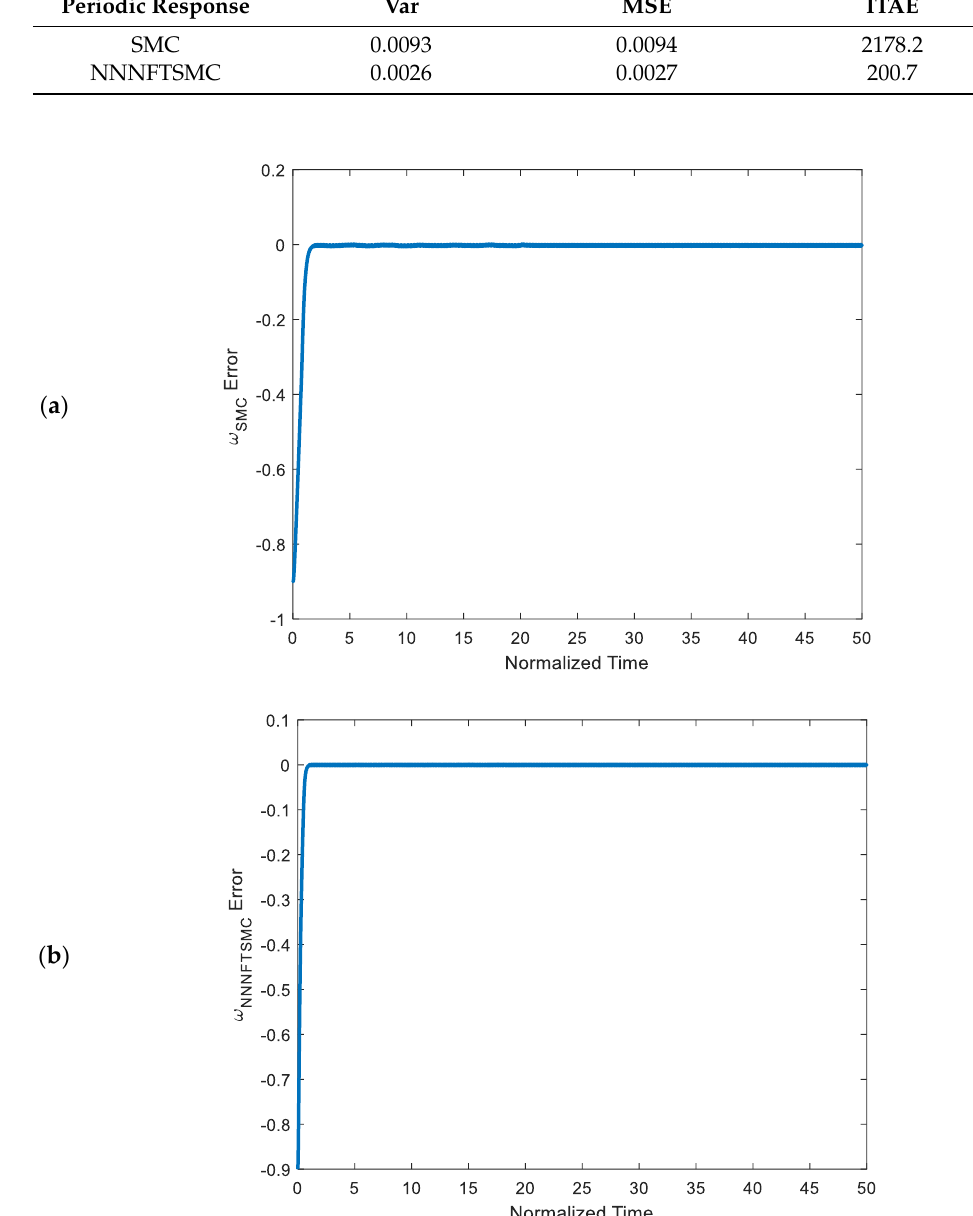
Figure 7. Position error of HTGS using ( a ) SMC and ( b ) proposed controller.